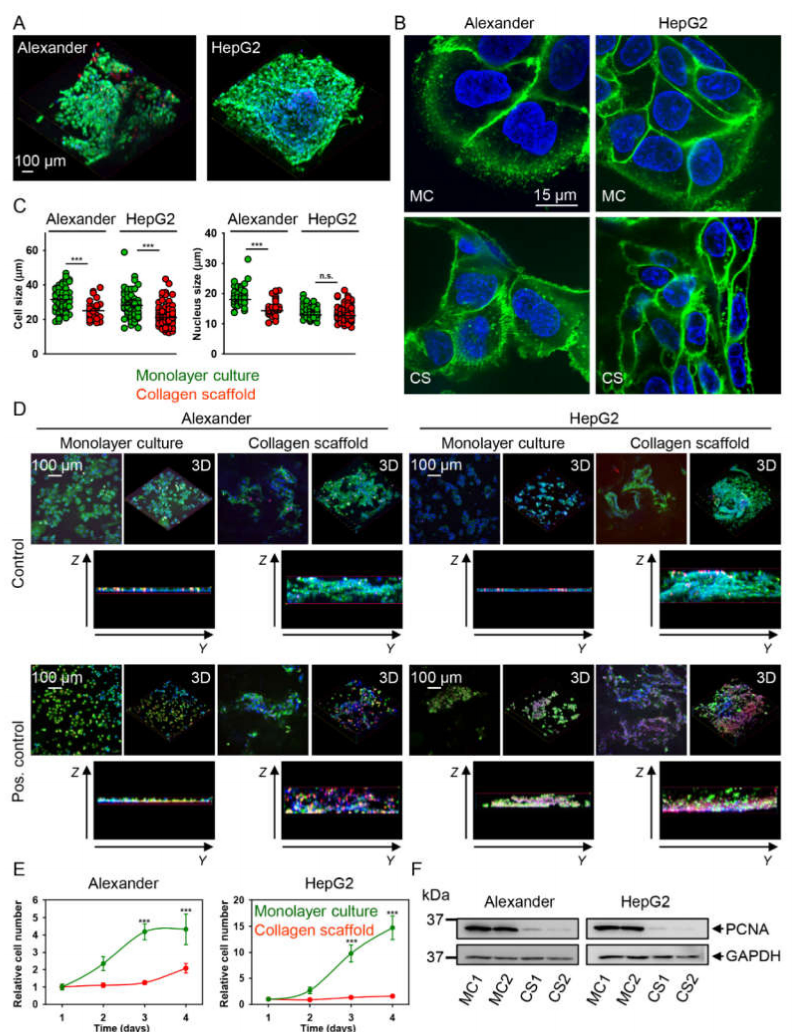
Figure 2. Hepatic cell size and plasticity under culturing in collagen sca ff olds. ( A ) Viability assessment. Cells were loaded with calcein-AM (green) and ethidium homodimer (red); images were acquired by confocal microscopy. Hoechst 33342 (blue) dye was used to counterstain nuclei. Three-dimensional reconstruction was done using ImageJ software (NIH). ( B ) HepG2 and Alexander cells were grown either in standard monolayer culture (MC) or in collagen sca ff olds (CS). Cell membranes were labeled with CellMask ™ Green (green). Hoechst 33342 (blue) dye was used to counterstain nuclei. Labeled cells were then imaged by confocal microscopy and the images were processed using ImageJ software (NIH). ( C ) Image quantitative analysis of cell and nuclei sizes was performed in ImageJ software (NIH). Quantifications are presented as means of n = 27–86 cells, (***) p < 0.001 denotes significant di ff erences. ( D ) HepG2 and Alexander cells were grown either in a standard monolayer culture or in collagen sca ff olds. Cell were labeled with CellMask ™ Green (green), as a membrane stain, and propidium iodide (red), as a dead cell stain. Hoechst 33342 (blue) dye was used to counterstain nuclei. Control cells were untreated. As a positive control, cells were treated with 20% ethanol for 60 min. Labeled cells were then imaged by confocal microscopy. ImageJ software (NIH) was used for image processing and 3D reconstruction. ( E ) Growth curves of HepG2 and Alexander cells either in standard monolayer culture or in collagen sca ff olds, (***) p < 0.001 denotes significant di ff erences. ( F ) Proliferating cell nuclear antigen (PCNA) expression was determined by immunoblotting; GAPDH—loading control. HepG2 and Alexander cells were grown either in a standard monolayer culture (MC) or in collagen sca ff olds